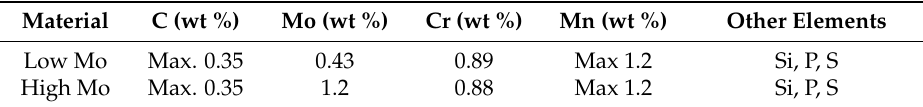
Table 1. Compositions of the two lab cast